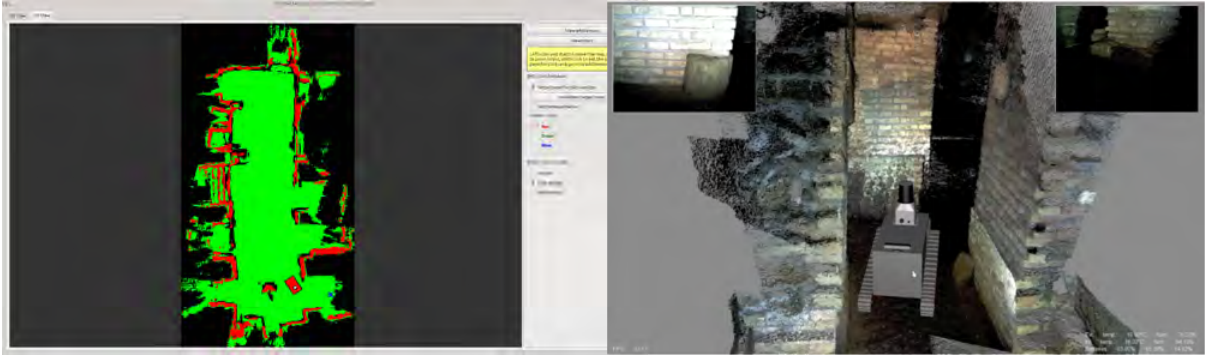
Figure 3. Mission Control interface Early